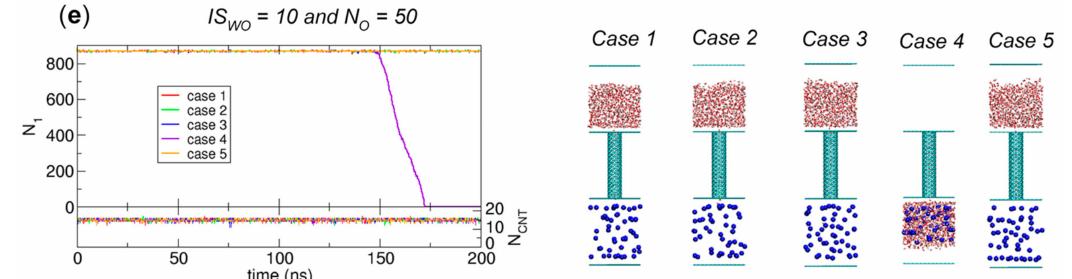
Figure 9. Results of 200 ns simulations for the systems of N O = ( a ) 70, ( b ) 65, ( c ) 60, ( d ) 55, and ( e ) 50 with IS WO = 10. For each system, we perform five independent simulations, and we plot the numbers of water molecules in Compartment 1 ( N 1 ) and the CNT ( N CNT ) as functions of time (left) with the final configurations at 200 ns from the five simulations